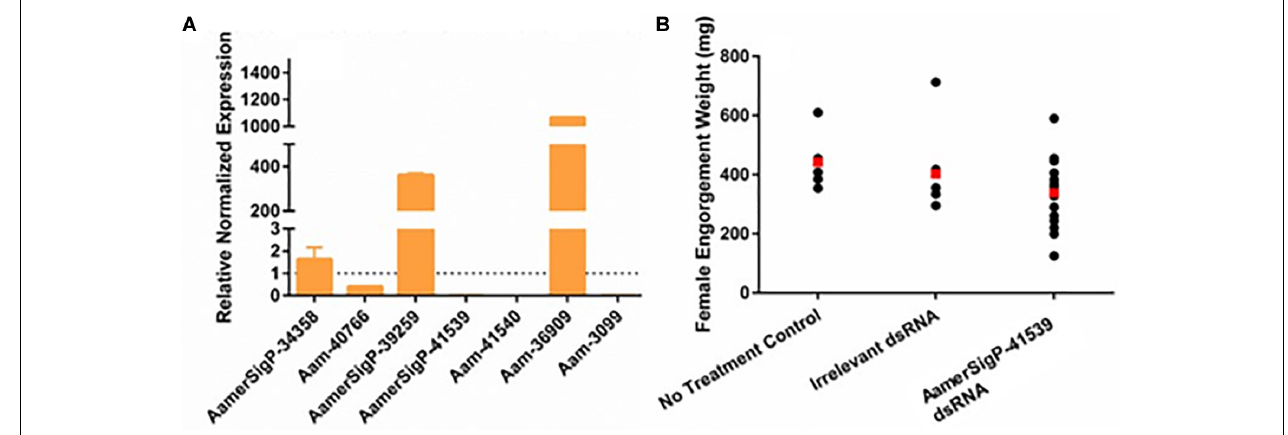
FIGURE 1 | RNA interference-based silencing of AamerSigP-41539 (glycine-rich protein gene) in the lone-star tick ( Amblyomma americanum ). (A) Compensatory transcriptional expression of selected grp genes was determined in AamerSigP-41539 silenced partially blood-fed tick salivary glands. (B) Mass of replete or forcibly removed 12 days fed female ticks. Ubiquitin was used as a housekeeping gene to normalize the transcriptional